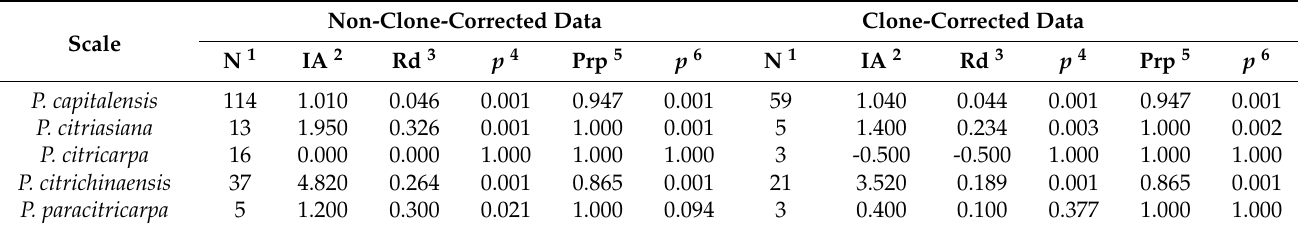
Table 3. Linkage disequilibrium and recombination analyses for five Phyllosticta species based on allelic information at six loci in this study.